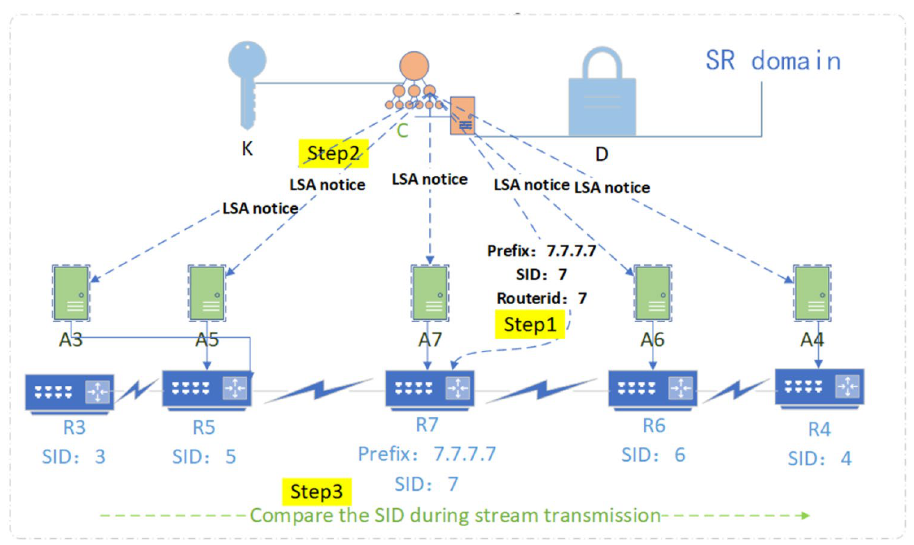
Figure 8. Schematic diagram of SR SID